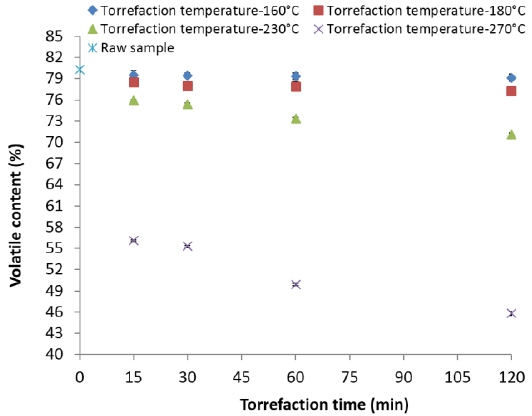
Figure 5. Volatile content in ground lodgepole pine with respect to the torrefaction temperature and time. and